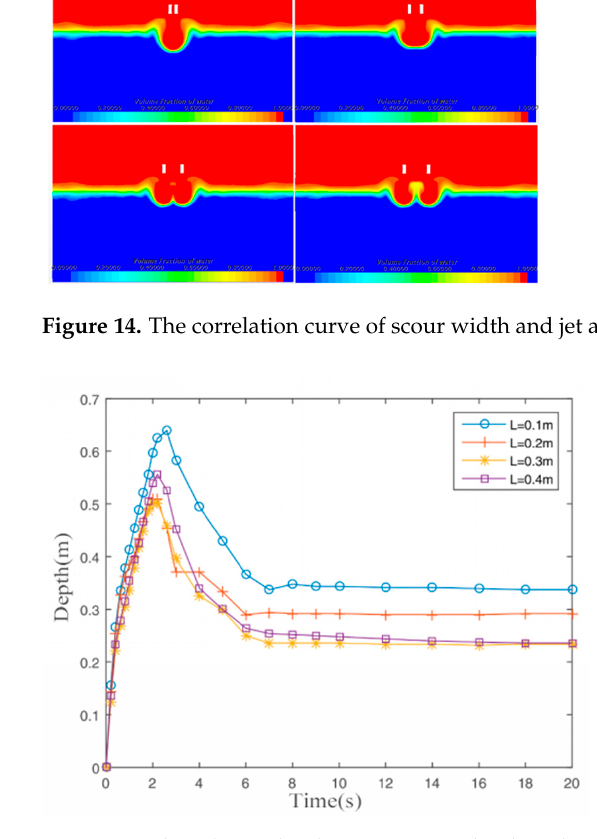
Figure 16. The correlation curve of scour width and jet spacing. It can be obtained from the figure that the scour depth decreases as the nozzle spacing increases. When the distance is greater than 0.3 m, the scouring depth will no longer change. Correspondingly, the scouring width will increase accordingly, but when the spacing is greater than 0.3 m, there will be siltation of unscoured soil in the middle of the trench, which is obviously undesirable.